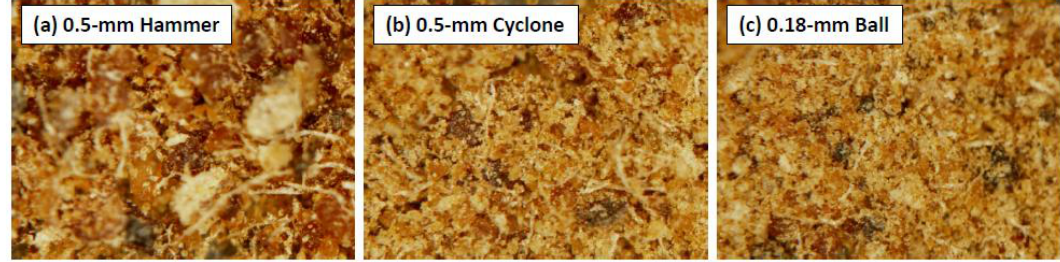
Figure 1. Stereomicroscopic images of WCSM products ground by three mills and passed by 0.5-mm and 0.18-mm screens, respectively.